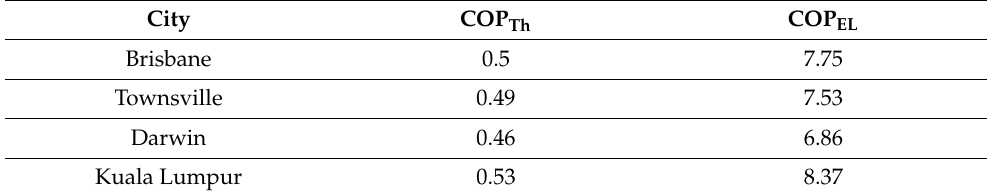
Table 2. Summary of energy performance indicators of the system operating in various cities. City COP Th COP EL Brisbane